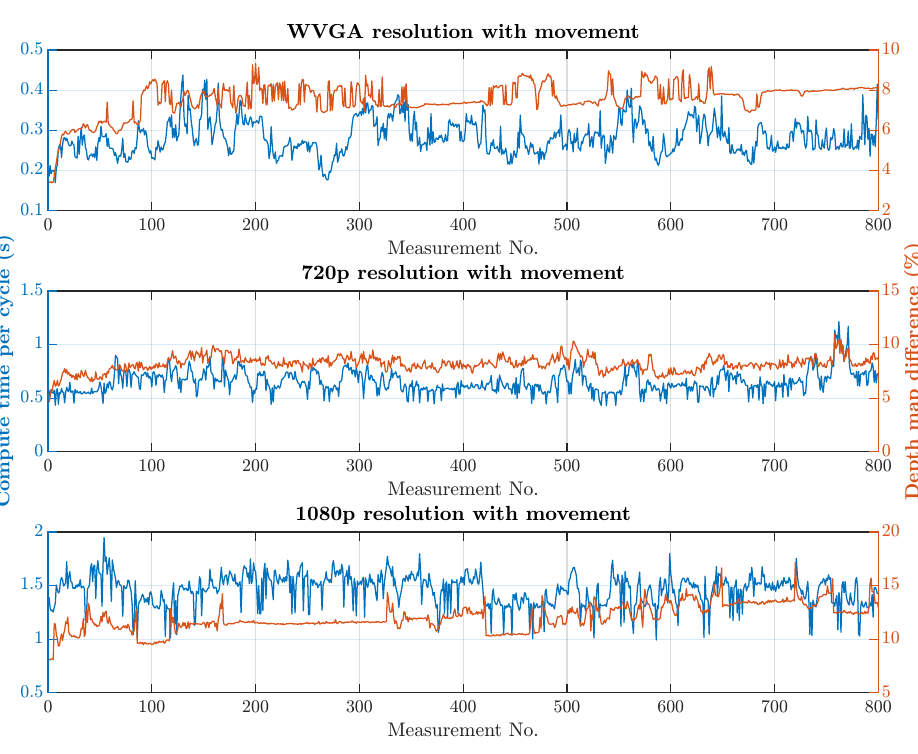
Figure 15. Results with HOG and without movement.